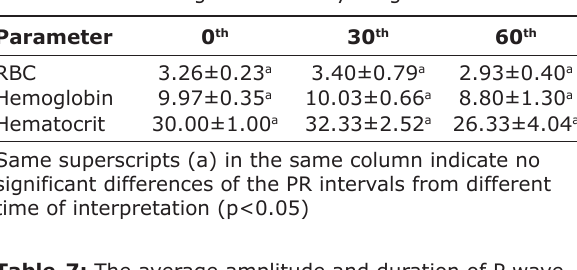
Table-6: The average result of erythrogram.